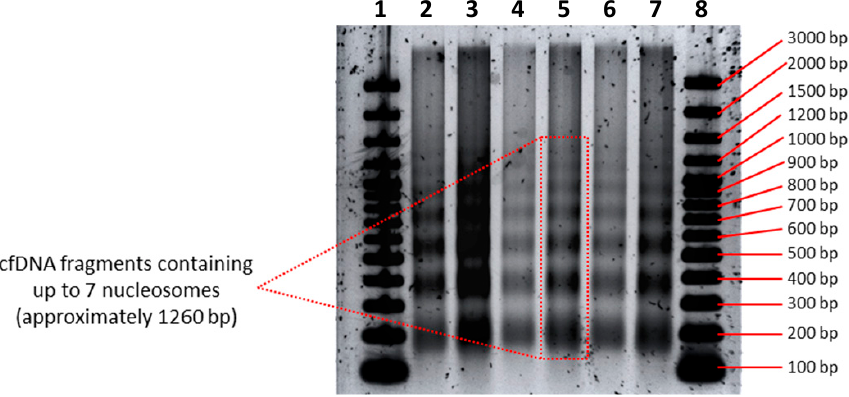
Figure 3. Cell-free DNA (cfDNA) separation and sizing by agarose gel electrophoresis. CfDNA was isolated from large volumes (~30 mL) of human bone osteosarcoma (143B) cell culture supernatant and loaded onto an agarose gel, revealing a clear laddering pattern showing seven distinct cfDNA populations up to seven nucleosomes in length. Wells 1 and 8 contain the GeneRuler 100 bp Plus DNA ladder. Wells 2, 4 and 6 were loaded with 60, 42 and 48 ng cfDNA, respectively (all containing 3 µ L cfDNA sample, 2 µ L loading dye and 3 µ L H 2 O). Wells 3, 5 and 7 were loaded with larger volumes of the same cfDNA samples, amounting to 100, 70 and 80 ng cfDNA, respectively (all containing 5 µ L cfDNA sample, 2 µ L loading dye and 1 µ L H 2 O). Electrophoresis parameters: pooled cfDNA samples concentrated with 30 KDa Amicon Ultra Centrifugal Filter Units were loaded onto a 10 cm-long TBE agarose gel (1.5%; 4 mm) and run with buffer TBE buffer (1X) for 90 min at 100 V. Before imaging, gels were stained with SYBR Gold Nucleic Acid Gel Stain for 40 min by gentle